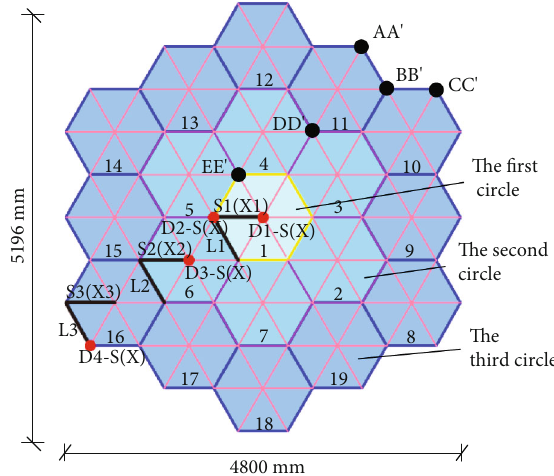
Figure 2: Module arrangement with the marked points and